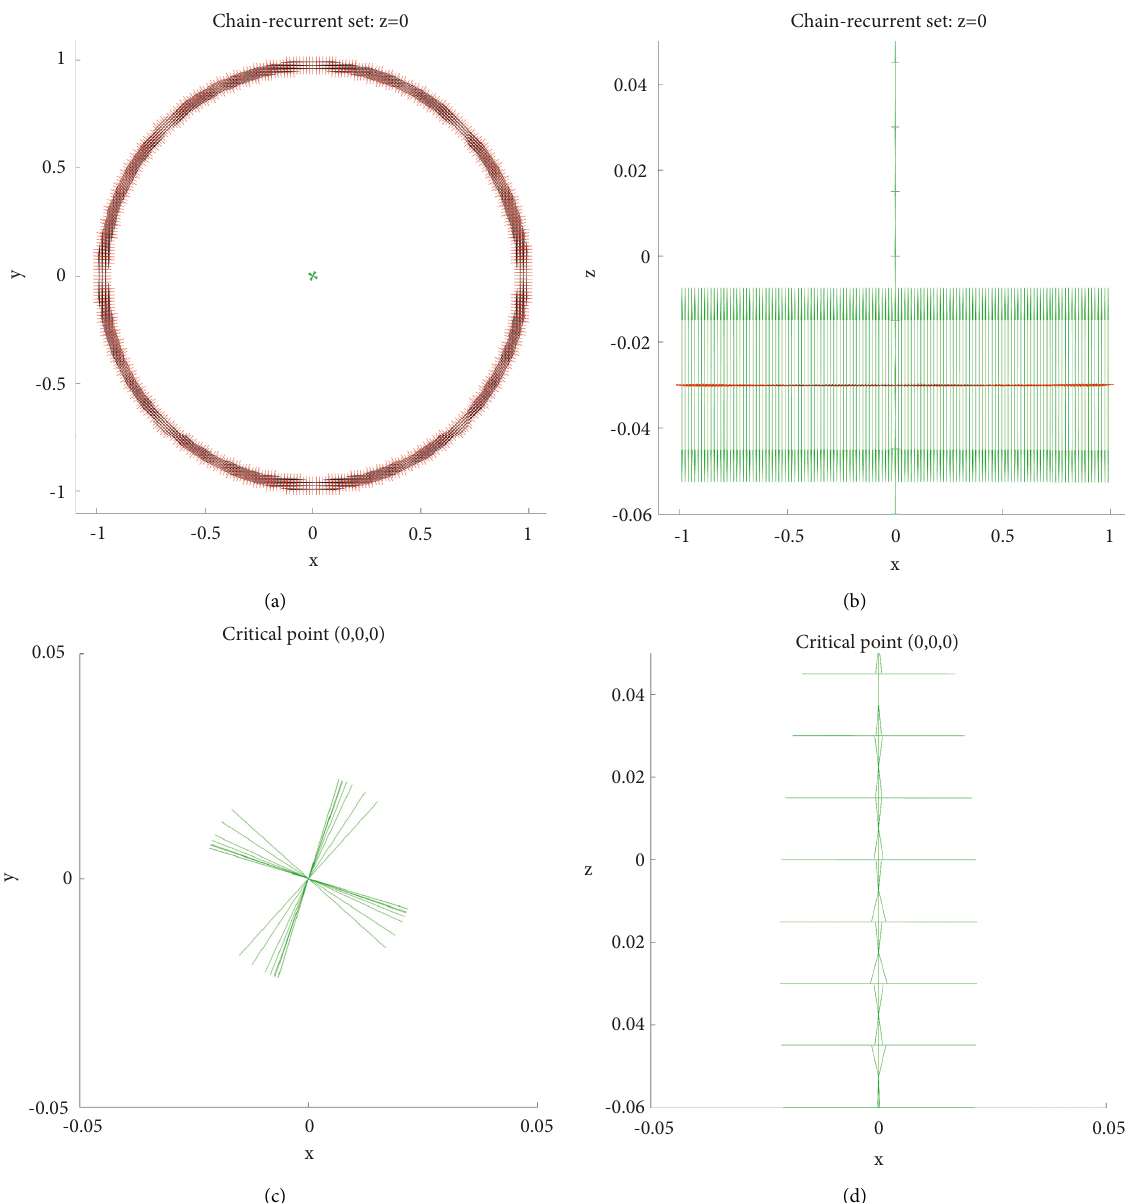
Figure 13: System (21). z � 0, periodic orbit Ω and equilibrium at ( 0 , 0 , 0 ) in the xy -plane (a) and in the xz -plane (b). Ω 0 dimensional unstable manifold (towards the equilibrium) and one-dimensional stable manifold (in z -direction). Equilibrium ( 0 , 0 , 0 ) in the xy -plane (c) and in the xz -plane (d) with a three-dimensional stable